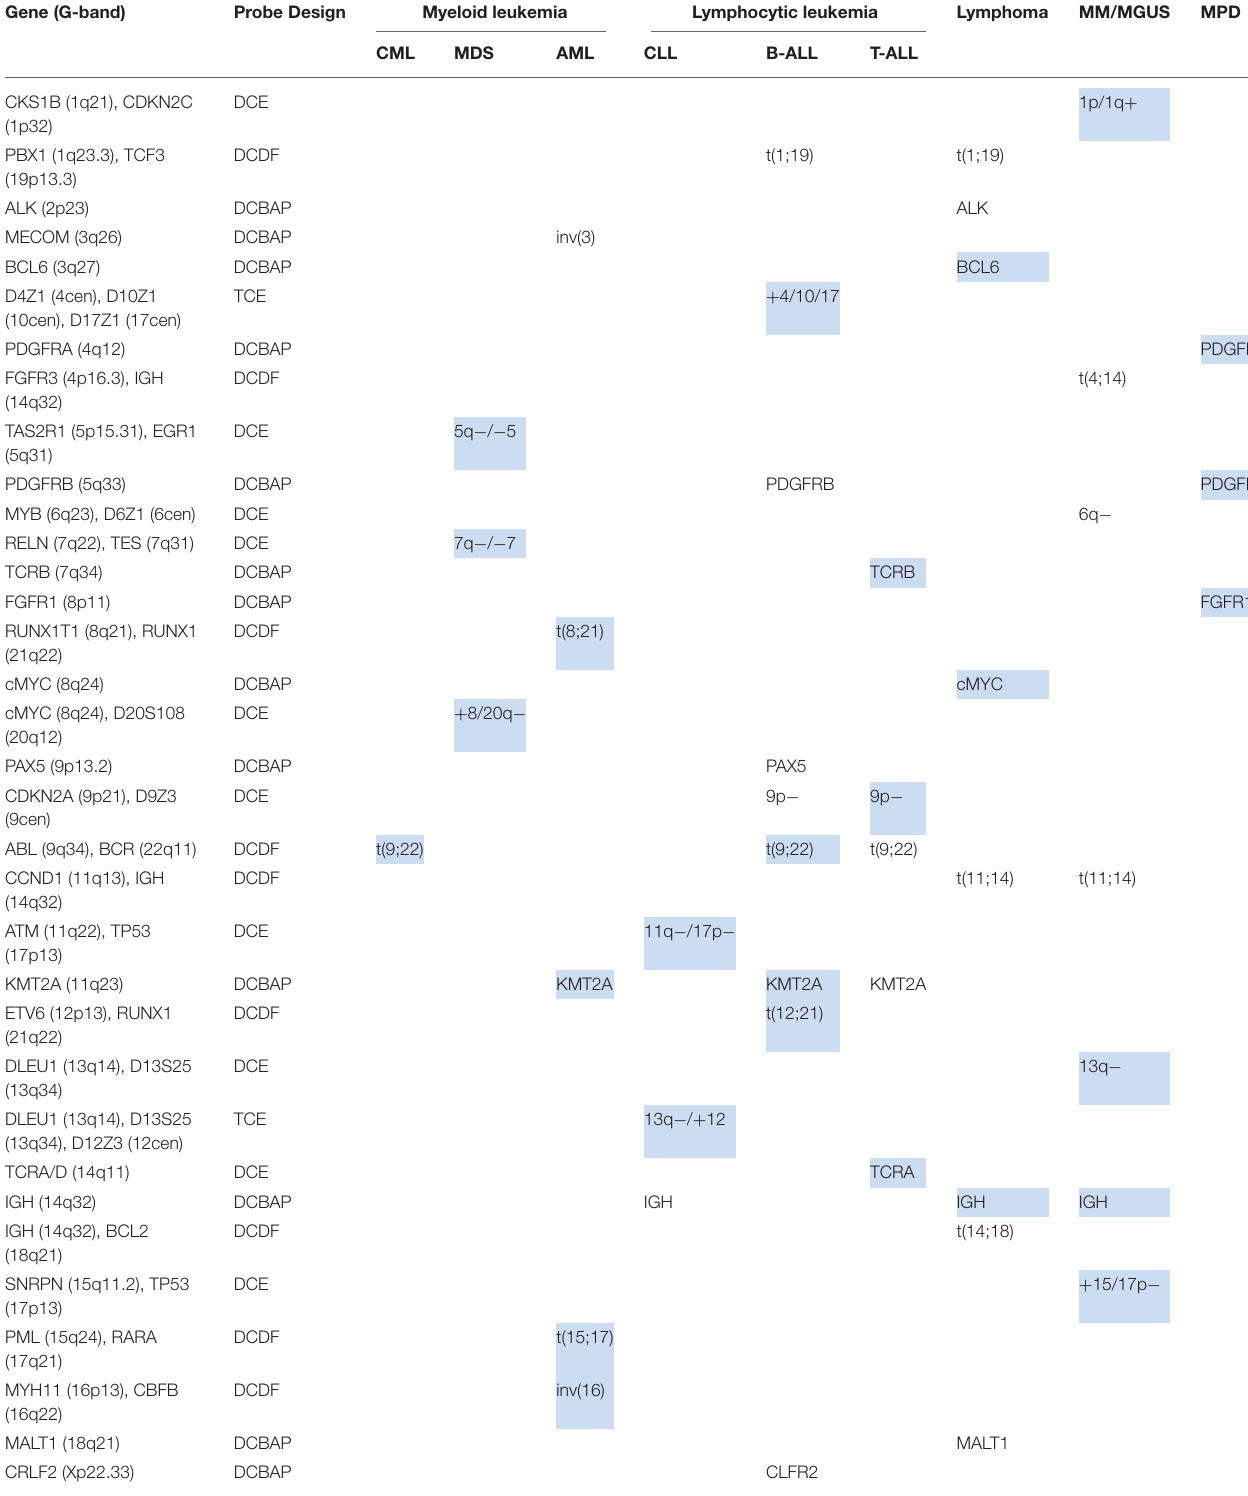
TABLE 1 | List of FISH panels and probes for hematopoietic and lymphoid tumors. Gene